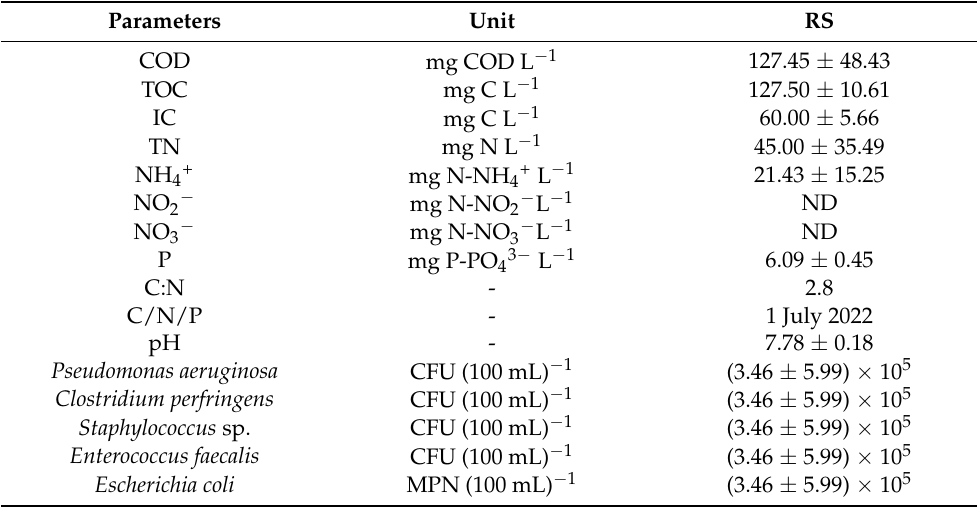
Table 1. Physical–chemical and biological characterization of RS during the experiment.